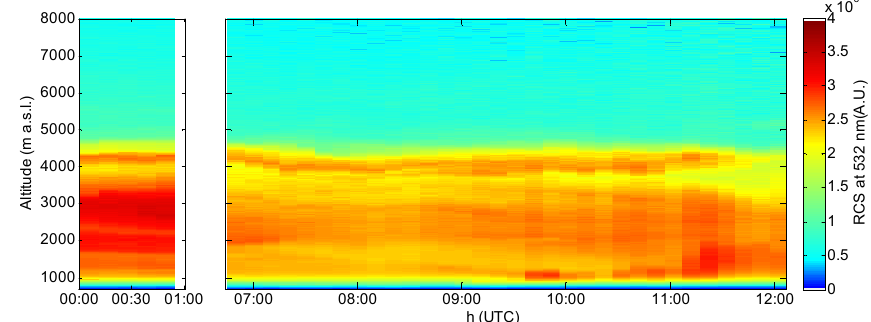
Figure 1. Time series of the RCS for the period 00:00–01:00 and 06:45–12:10UTC on the 27 June